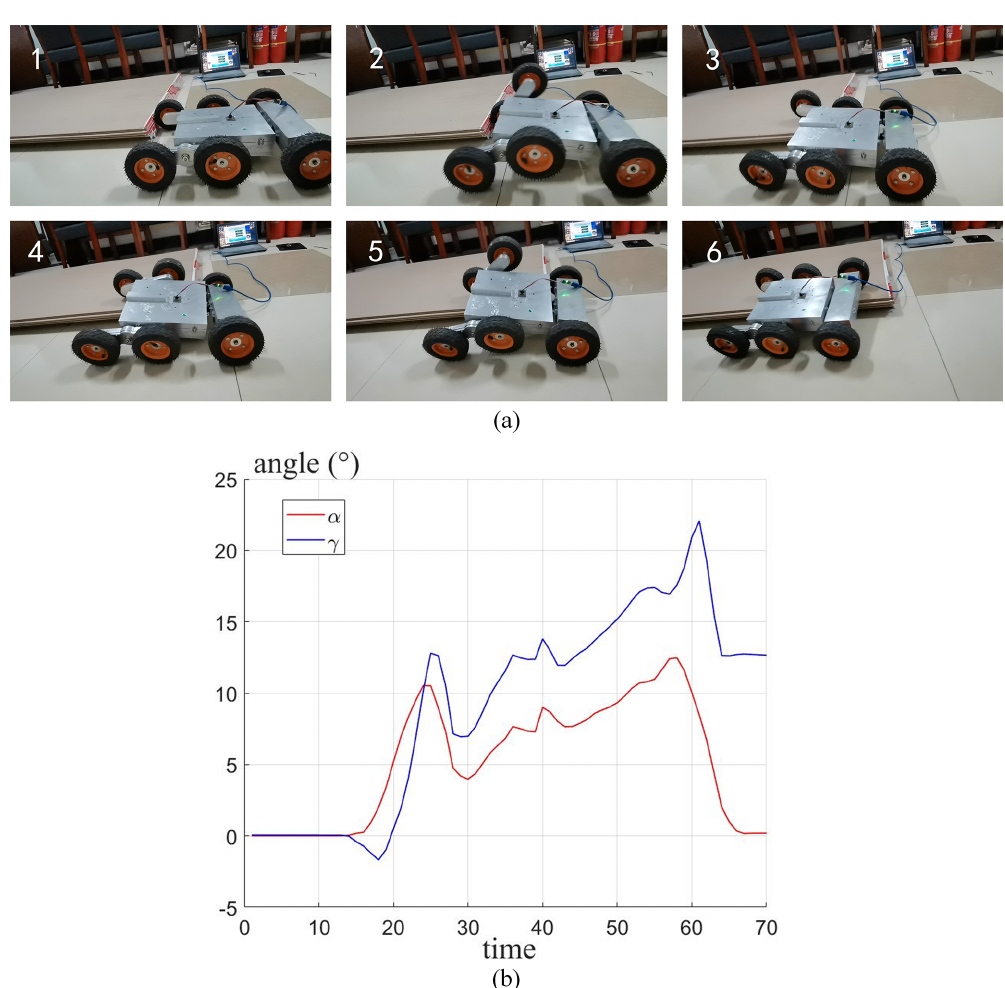
Figure 24. Experiment of the robot climbing 80mm vertical obstacle unilaterally and the curves of the pitch and roll angle of the robot obstacle crossing.